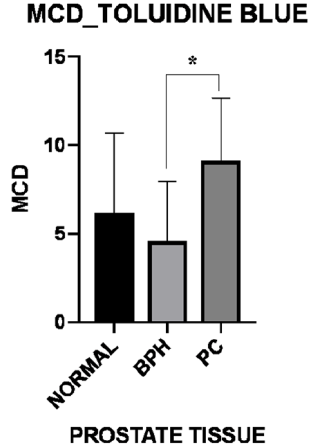
Figure 1. Total (periglandular/peritumoral and intraglandular/intratumoral) mast cell density (MCD) evaluated in Toluidine Blue-stained sections of normal, benign prostate hyperplasia (BPH) and prostate carcinoma (PC) samples. The graph shows an increased MCD in the PC group, compared to the other groups. The asterisk indicates significance ( p = 0.033) of the comparison between BPH and PC.